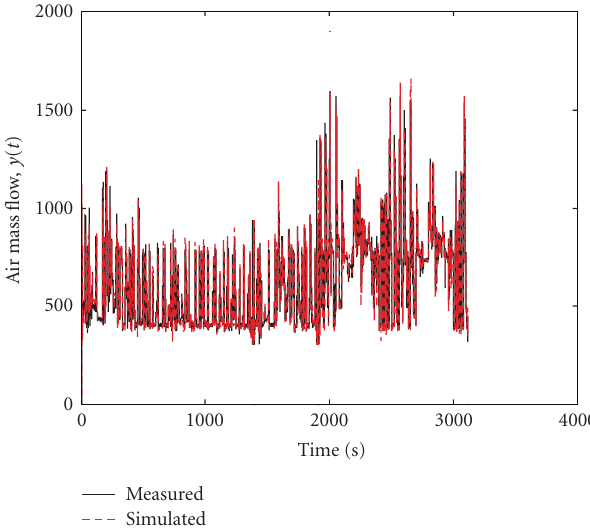
Figure 5: Compared actual and simulated intake air flow.